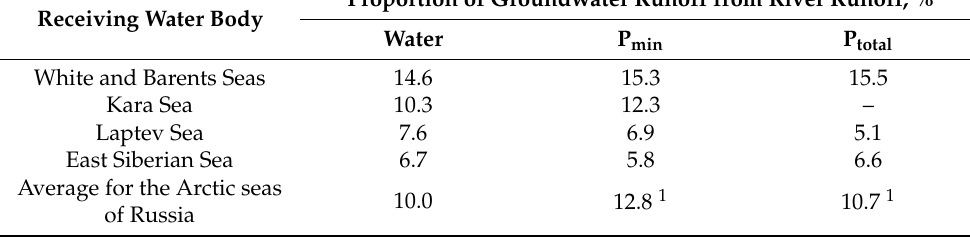
Table 15. The proportion of dissolved phosphorus in groundwater and river runoff into the marginal seas of the Russian Arctic